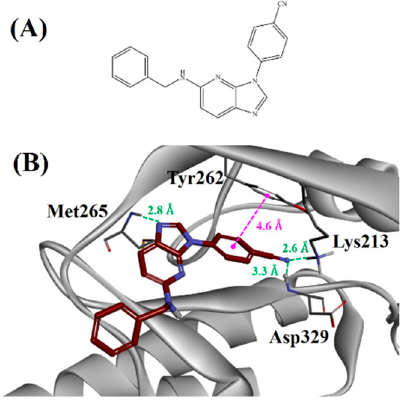
Figure 7. ( A ) Two-dimensional structure of compound 3 . ( B ) Binding mode of compound 3 against IRAK4. The green and magenta lines represent hydrogen bond and hydrophobic interactions, respectively.